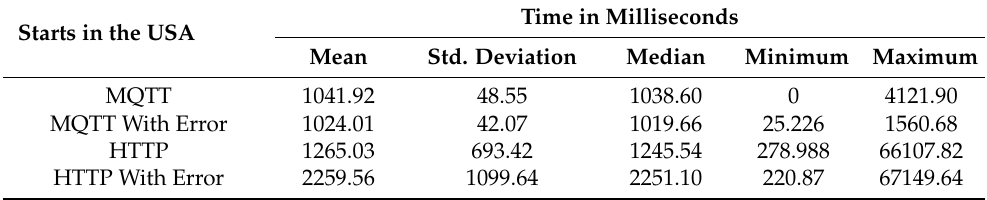
Time in Milliseconds Std.